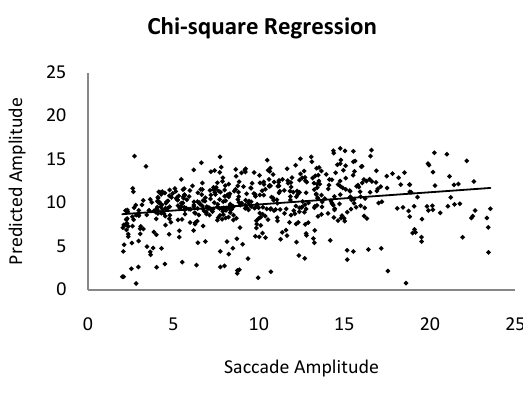
Figure 6. Direction error distribution according to